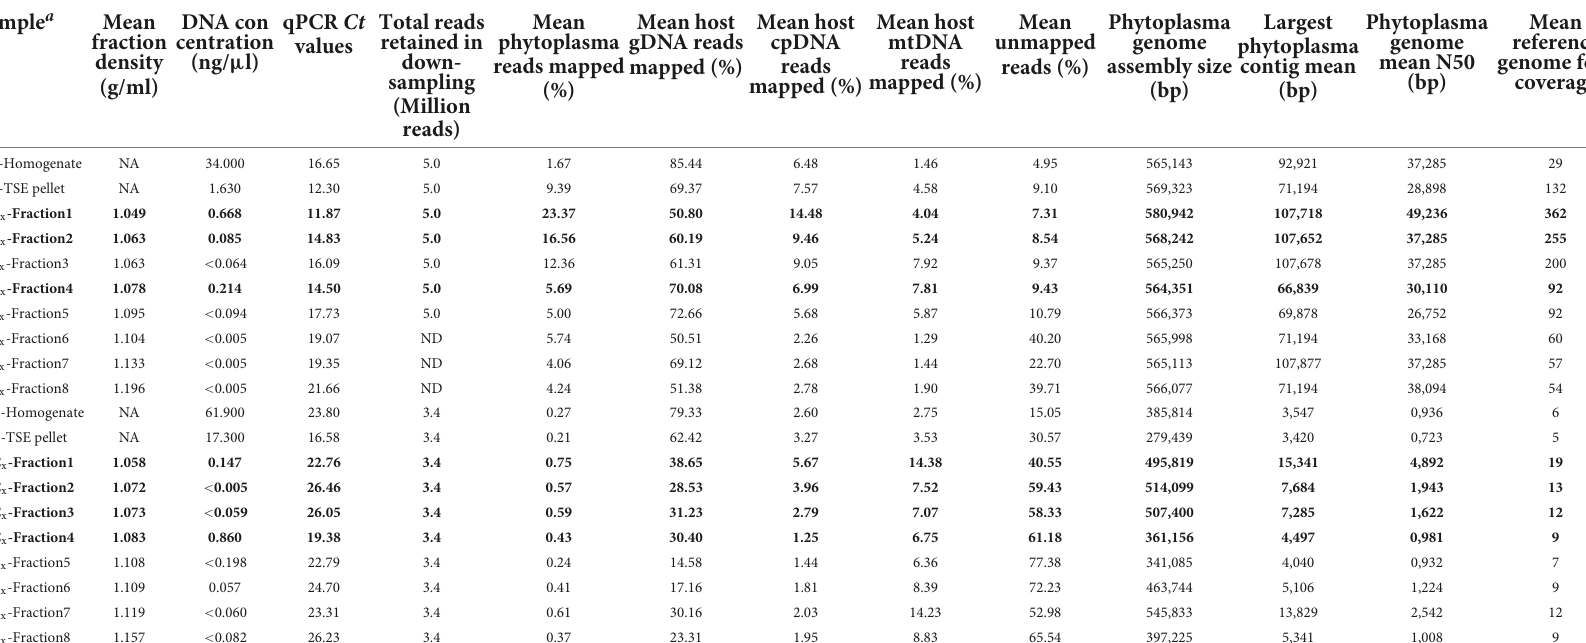
TABLE 3 Summary of iodixanol fraction densities after gradient centrifugation of phytoplasma infected potato (o4P) and capsicum (o7C) tissues, based on three ( x ) technical replicates of density gradient centrifugation for each sample; DNA concentrations of all samples; mean qPCR standard curve-based estimates of phytoplasma titer for all samples; HTS read mapping results after read down-sampling; and phytoplasma genome assembly quality metrics of down-sampled libraries. Sample